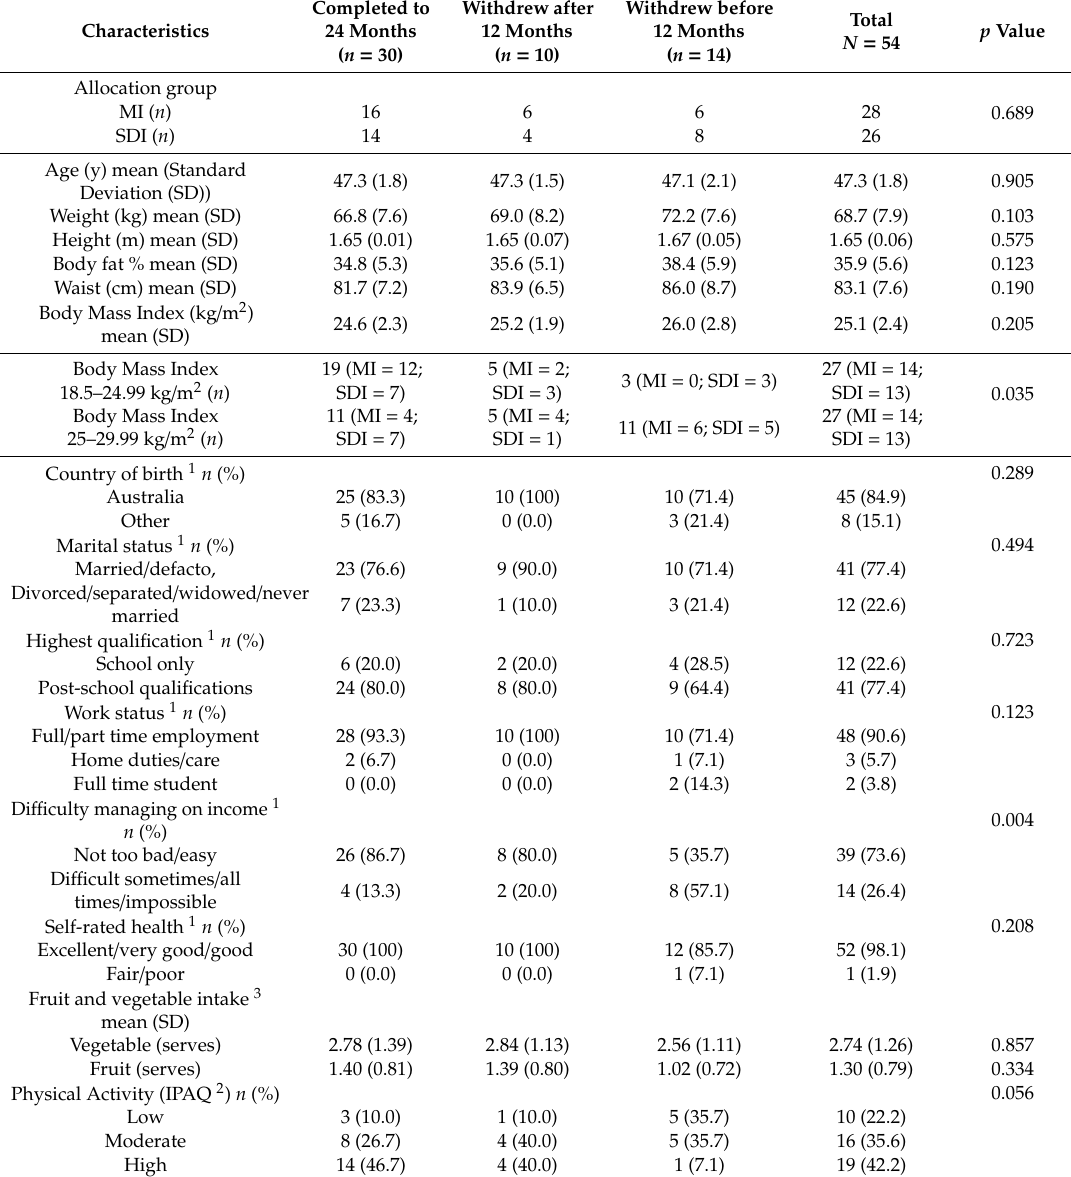
Table 1. Baseline characteristics of participants according to level of